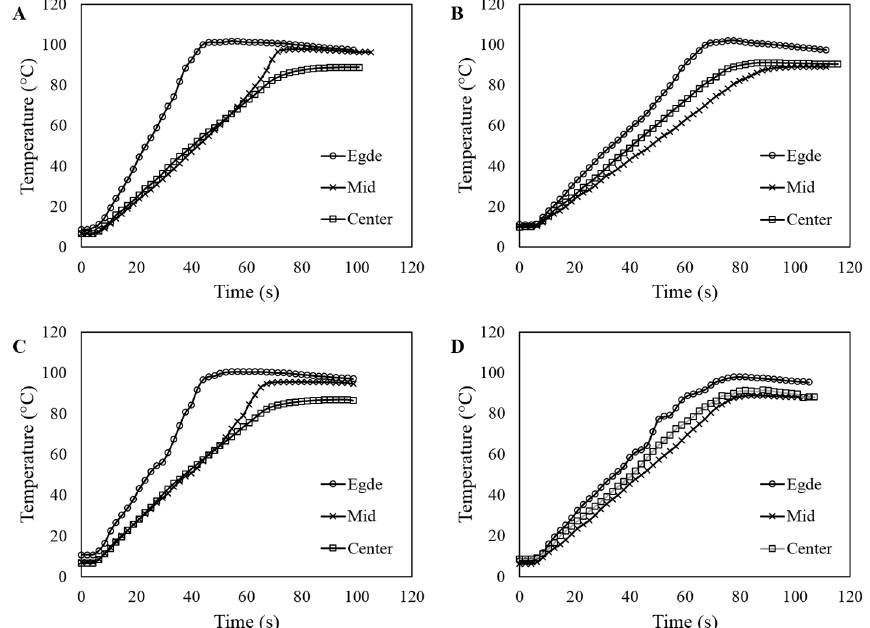
Figure 3. Time–temperature profile at the edge, mid-way, and the center position of the pork patties containing different salt and water levels in the container with a center-perforated lid during microwave heating. ( A ) Pork only (PL), ( B ) Pork + salt 2% (PS), ( C ) Pork + water 10% (PW), ( D ) Pork + salt 2% + water 10% (PSW).